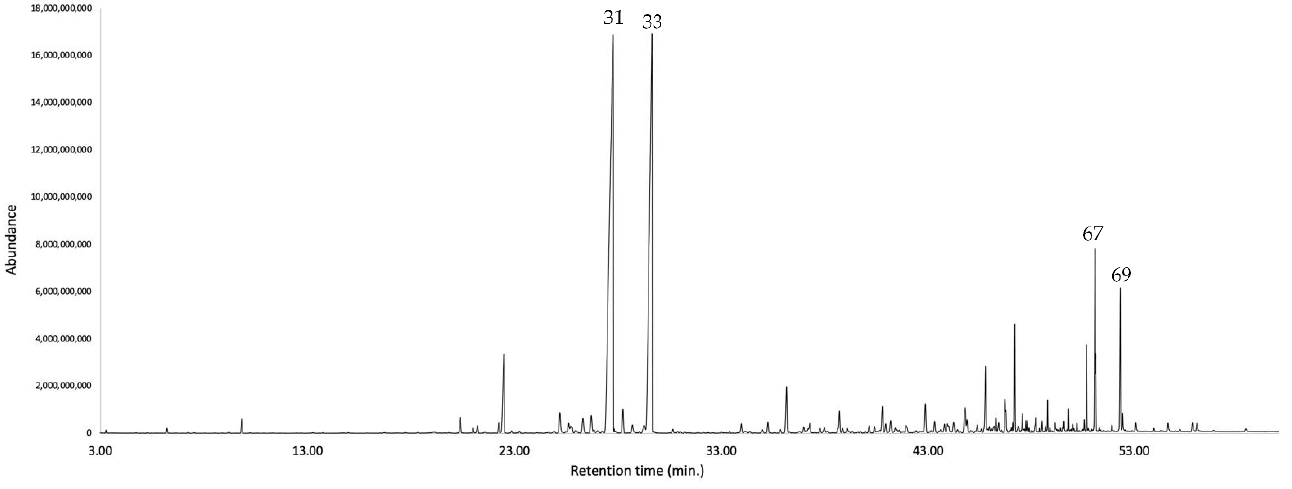
Figure 5. GC-MS chromatogram of K. longipetiolata EO on a polyethylene glycol stationary phase column. The peaks are numbered according to the order of oil components listed in Table 1. Table 1. Chemical analysis of Kaunia longipetiolata essential oil on 5%-phenyl-methylpolysiloxane and polyethylene glycol GC columns. The progressive numbers are referred to peaks in Figures 4 and 5.